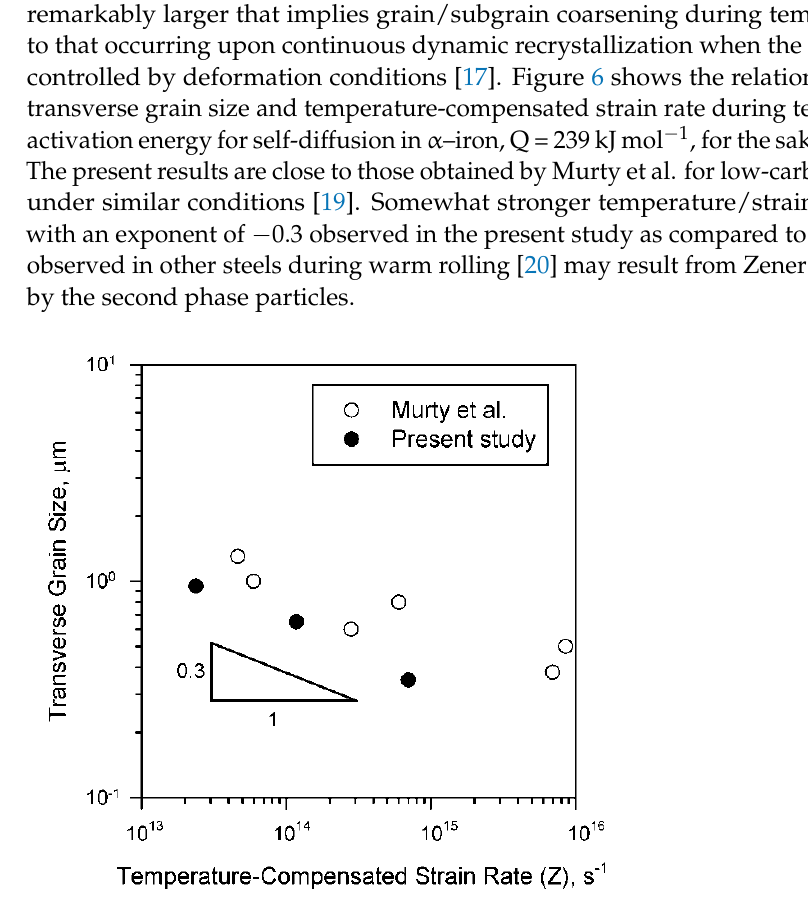
Figure 6. Effect of deformation conditions on the transverse grain size in an HSLA steel subjected to tempforming (black symbols) and low carbon steel after large strain compression (open symbols) [19].